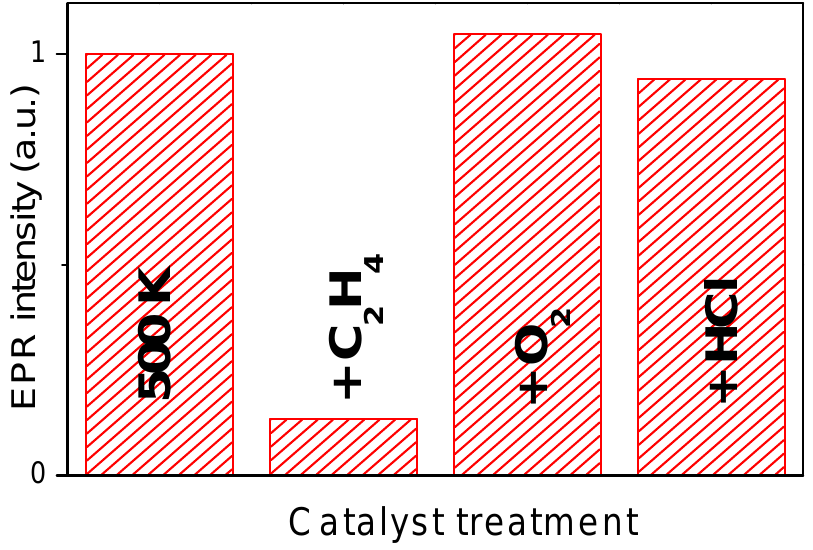
Figure 6. Integrated signal extracted from the EPR spectra collected at 77 K on Cu5.0 catalyst along the catalytic path. Sample activated at RT, at 500 K and after interaction with C value obtained on the catalyst activated at RT has been arbitrarily set